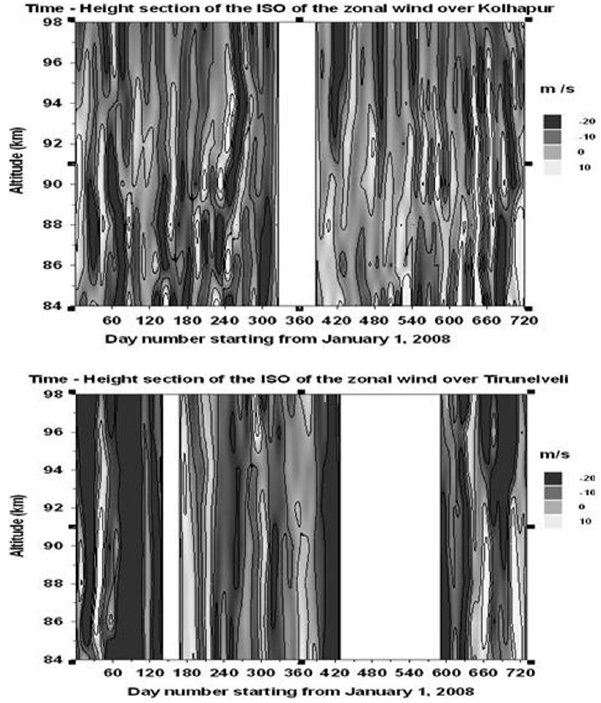
Fig. 4. Time-height sections of the ISO of the zonal winds (ms − 1 ) over Kolhapur (KOL) and Tirunelveli (TIR) for the observational period 1 January 2008–31 December 2009.